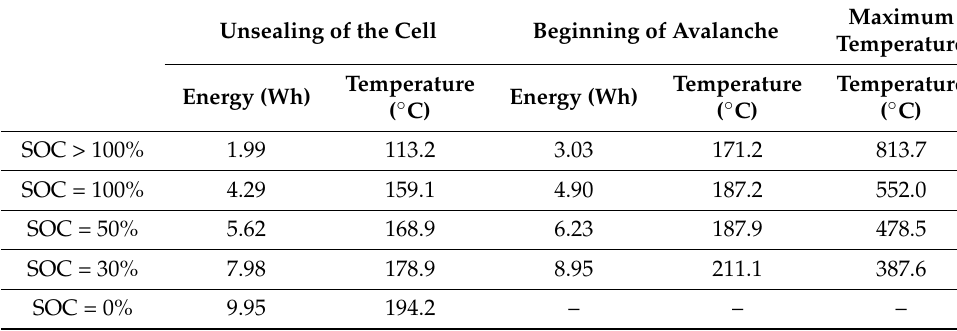
Table 4. List of ignition parameters of cells in different states of